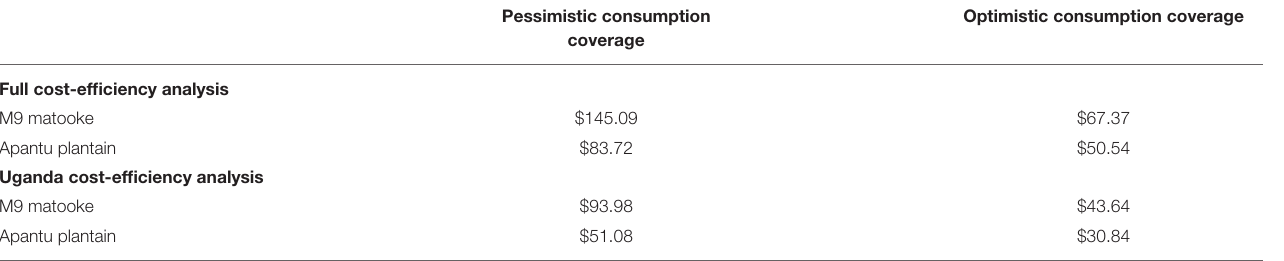
TABLE 3 | Cost per DALY saved by the four HpVA